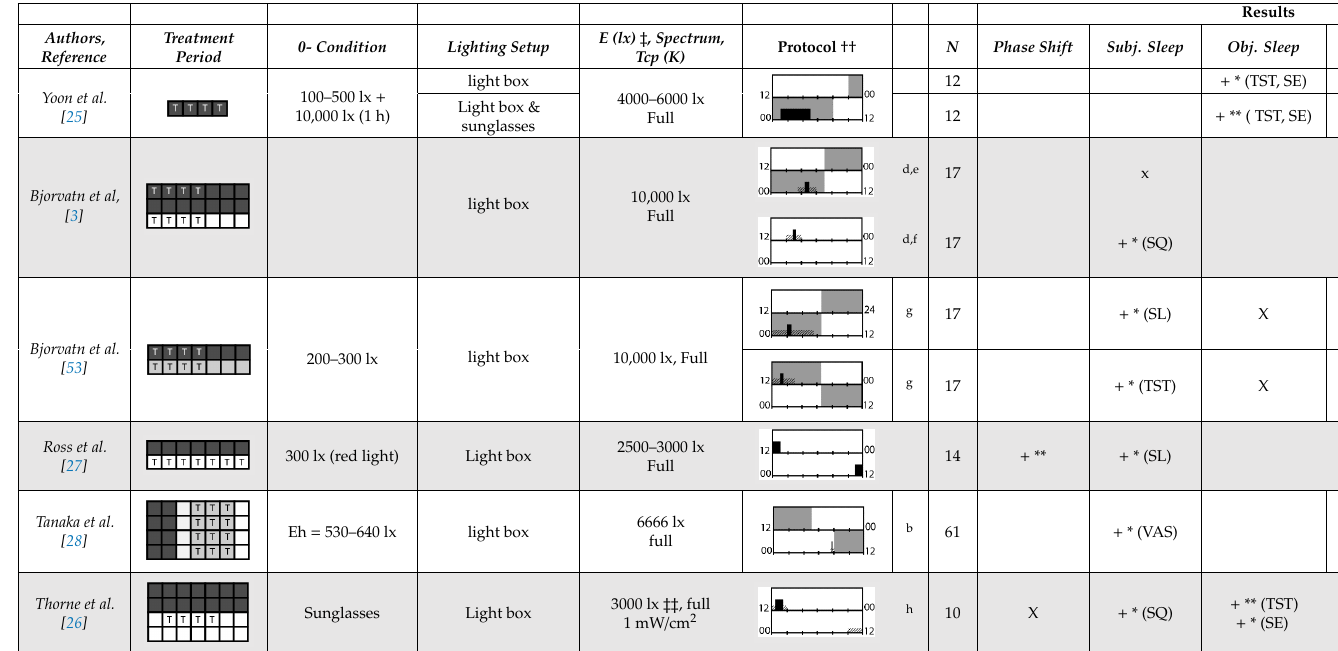
† dark-grey areas = nightshift; light-grey areas = day shift; T = light exposure treatment; ‡ presumably measured at eye-level; ‡‡ continuously measured; †† black areas = light exposure; grey areas = work shift; dashed areas = varying timing; a as workload permitted; b self-selected; c progressive extension of exposure duration to 7 h across days; d start of treatment scheduled 3 h before habitual awakening; e delay of scheduled start 1 h per day; f delay of scheduled start 2 h per day; g start of treatment ≥ 2 h before habitual awakening; h advance of scheduled start 1 h per day; * = p < 0.05; ** = p < 0.01; *** = p < 0.001; + = positive effect; x = no effect; CBT = core body temperature; UaMT6s = urinary 6-sulfatoxymelatonin; Cort. = cortisol; ISI = Insomnia Severity Index; Mel. = melatonin; SE = sleep efficiency; SL = sleep latency; SQ = sleep quality; TST = total sleep time; HADS = hospital anxiety depression scale; WASO = wake after sleep onset; ATS = accumulated time of sleepiness; VAS = visual analogue scale; CISQ = checklist individual